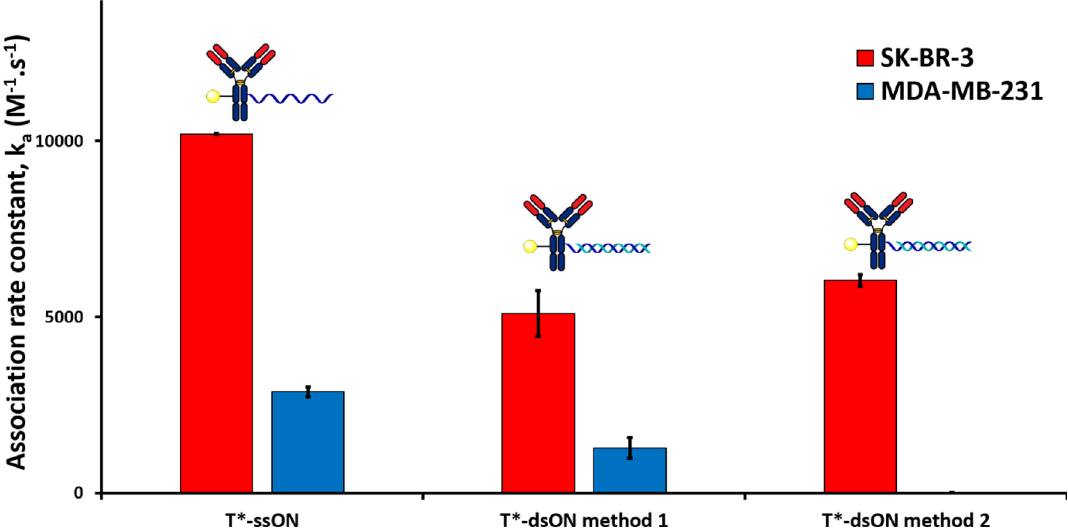
Figure 6. Association rate constants (k a ) of single and double stranded trastuzumab-ssON conjugate (T*-ssON and T*-dsON, respectively), and free single and double stranded ONs (ssON* and dsON*, respectively) on SK-BR-3 (HER2 + cell line, red bars) and MDA-MB-231 (HER2 − cell line, blue bars) measured using the time- resolved analysis of ligand binding assay (Fig. S4-6). The symbol * indicates fluorescein-labelling. Regarding the T*-dsON conjugates modes of preparation, method 1 corresponds to the hybridization of the complementary ON strand with the T-ssON conjugate, while method 2 corresponds to the conjugation of a hybridized dsON to trastuzumab (see Fig. 5). Error bars indicate the standard error of the fitted parameter k a